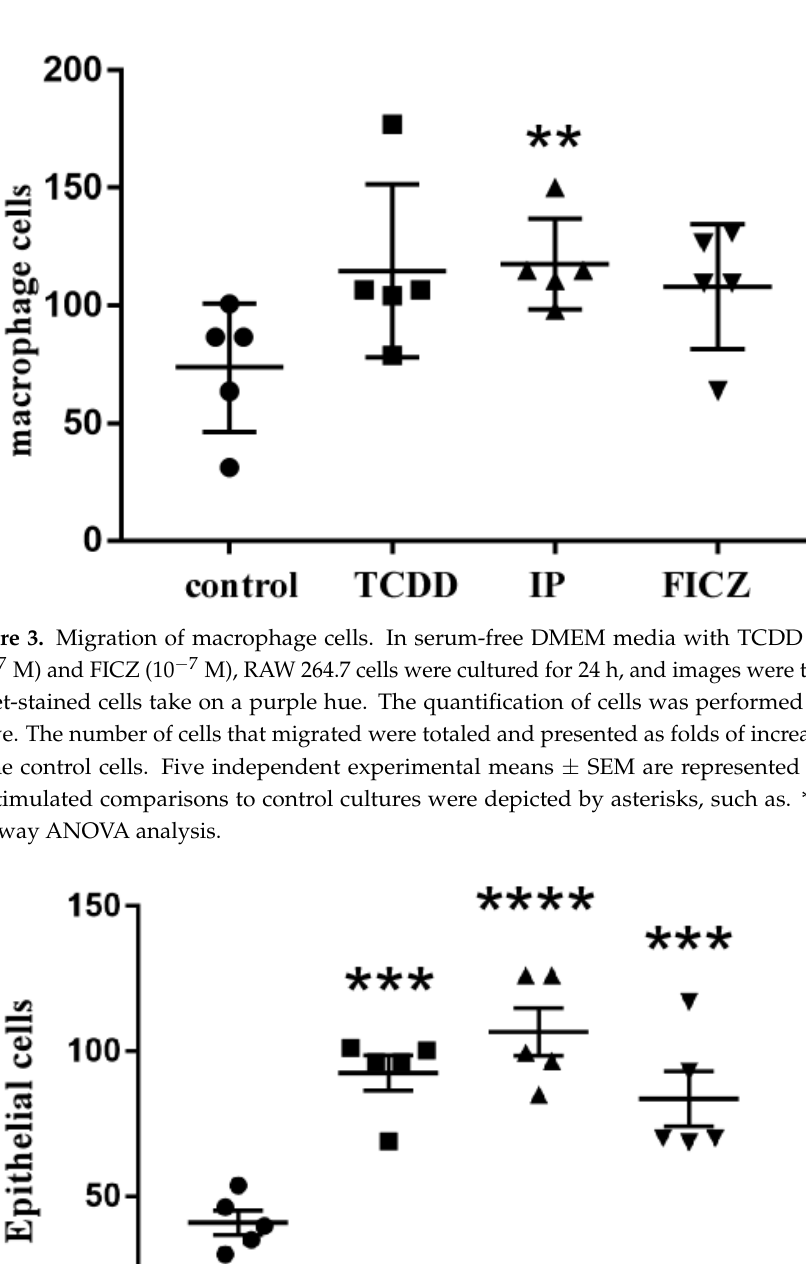
Figure 5. Effect of conditioned medium. In serum-free DMEM media with TCDD (10 −8 M), IP (10 −7 M), FICZ (10 −7 M) for 24 h, RAW 264.7 cells were maintained. MLE-12 cells were seeded for 10 – 12 h